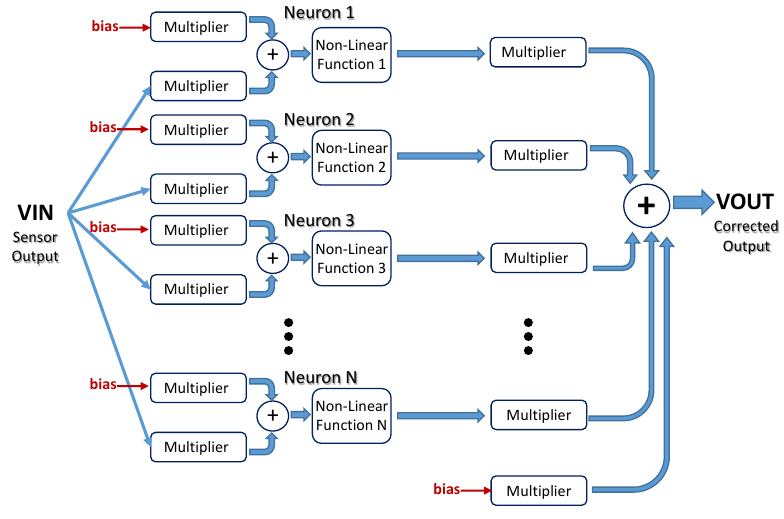
Figure 8. Detailed block diagram of the